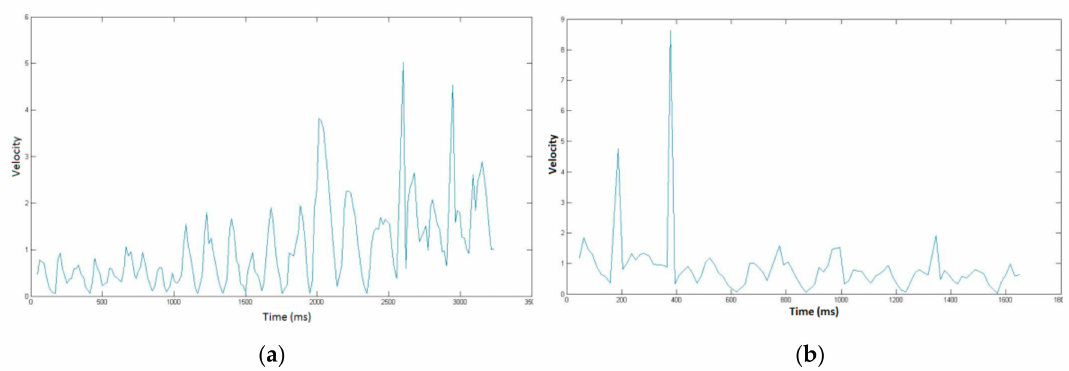
Figure 2. Velocity profile of ( a ) the usual signature and ( b ) the associated place information displayed in Figure